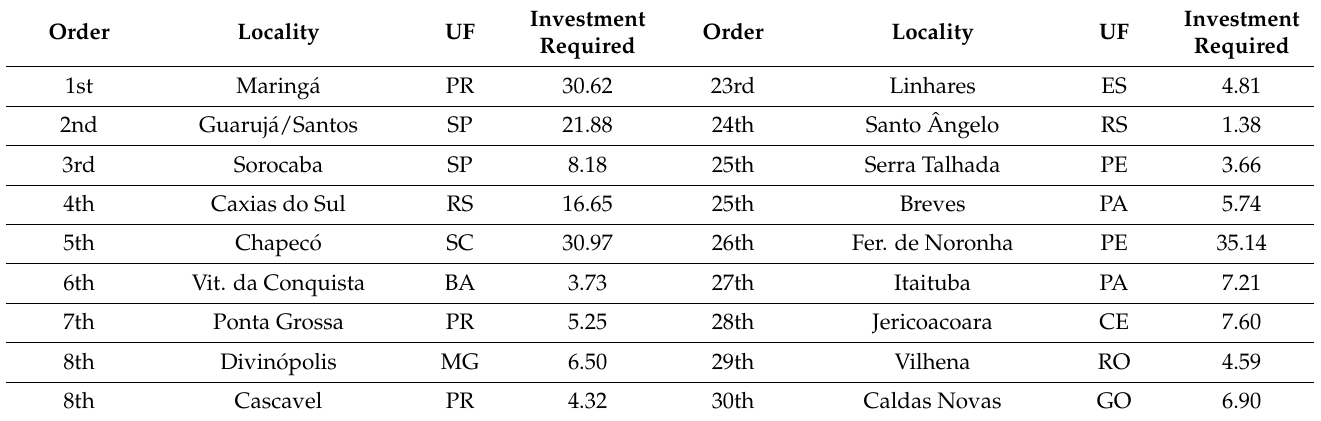
Table 12. Investment required by locality (million